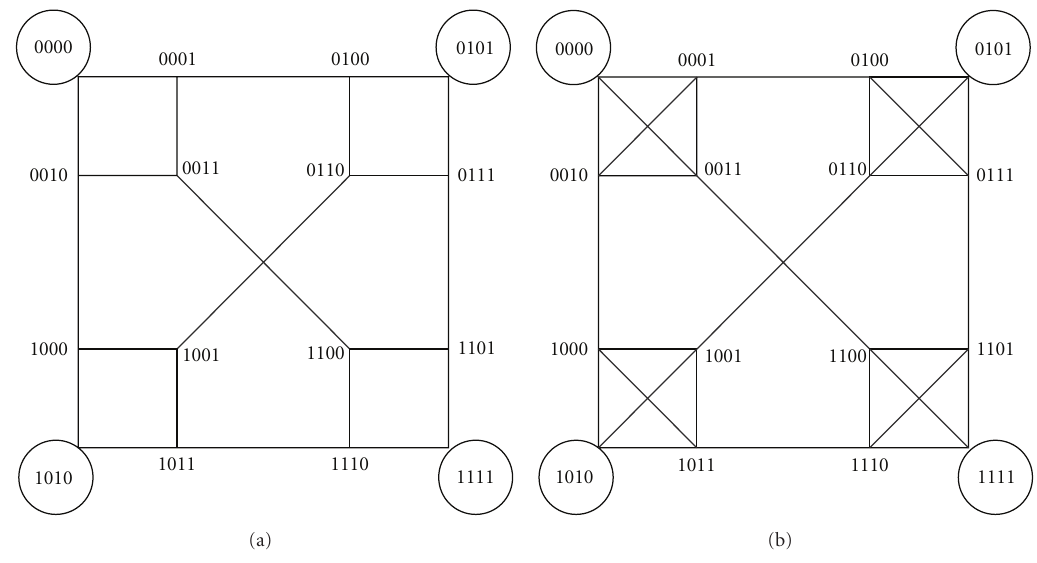
Figure 4: (a) A BSN(1,2) with N = 16, (b) A BSN(2,2) with N = 16